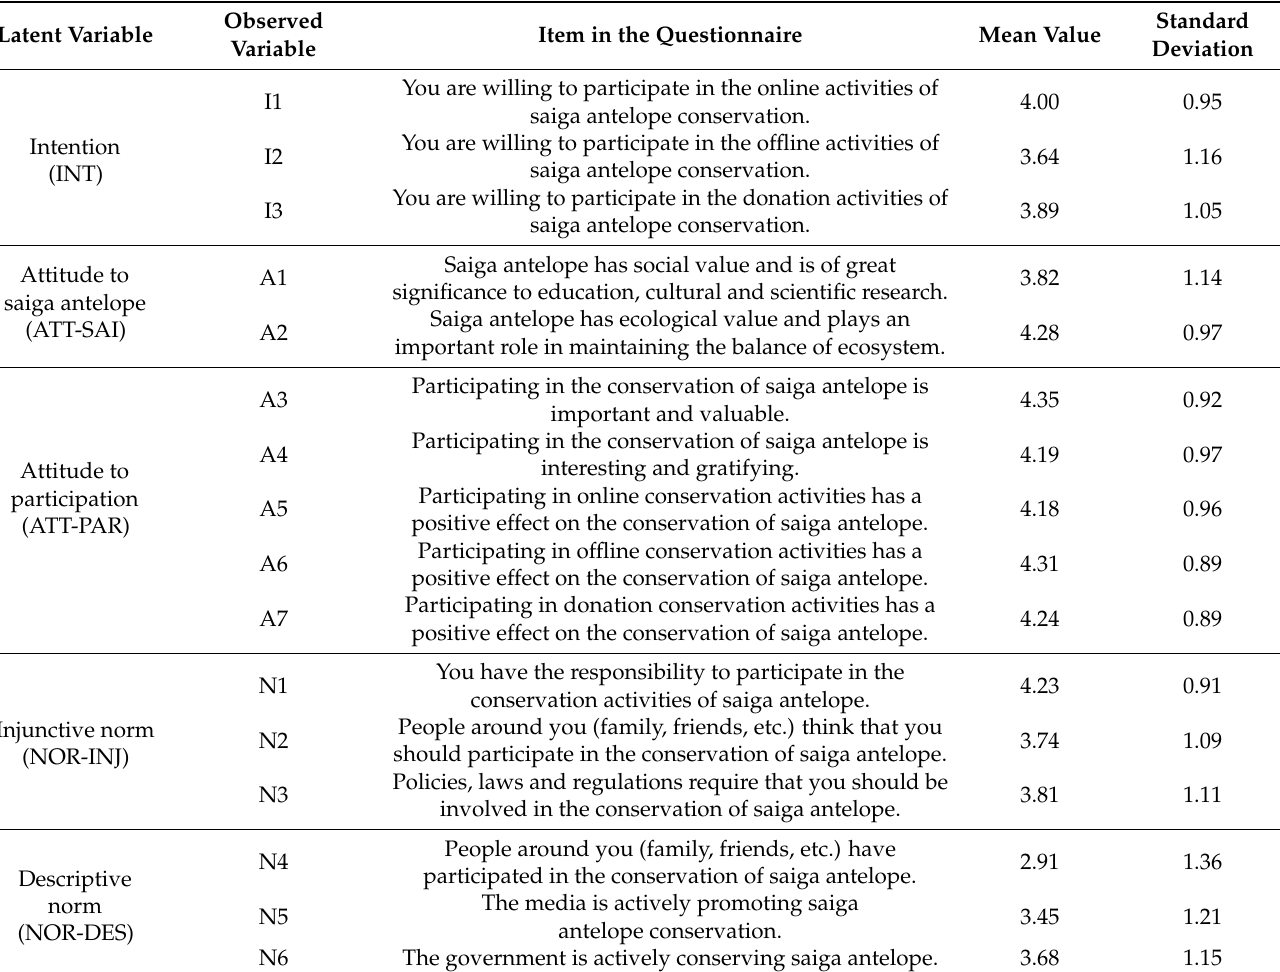
Table A1. Measurement items and descriptive statistics of them ( n =